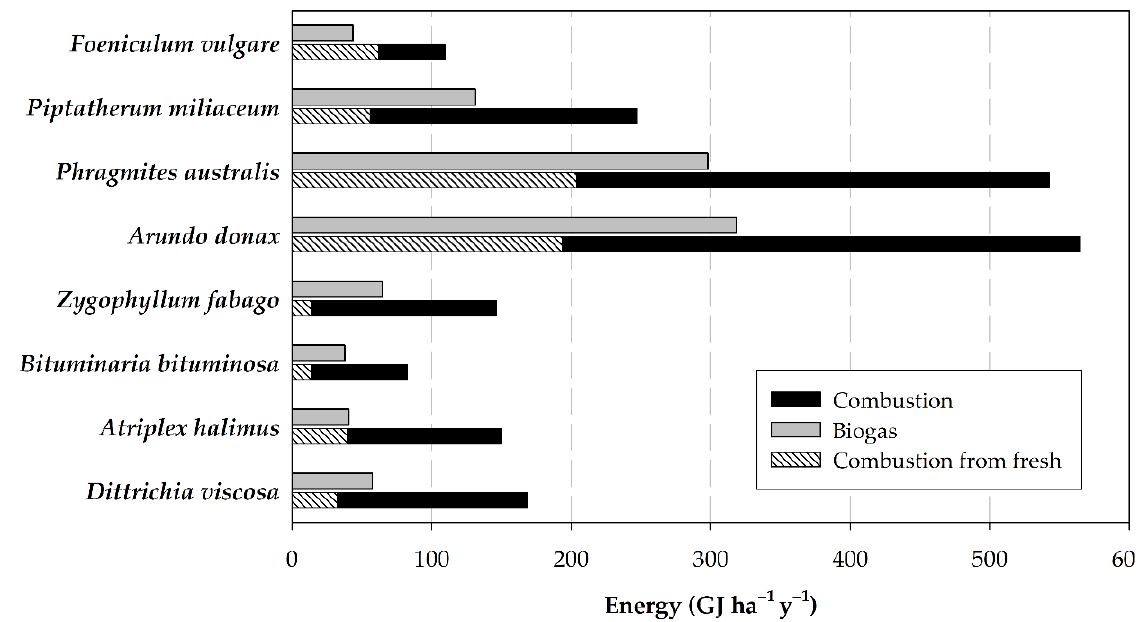
Figure 2. Potential energy production per hectare of land of the different plant species, by combustion (according to LHV) and by biogas production through anaerobic digestion. Comparison of the energy generated by combustion from the dry biomass (solid) and from the fresh biomass (dashed).